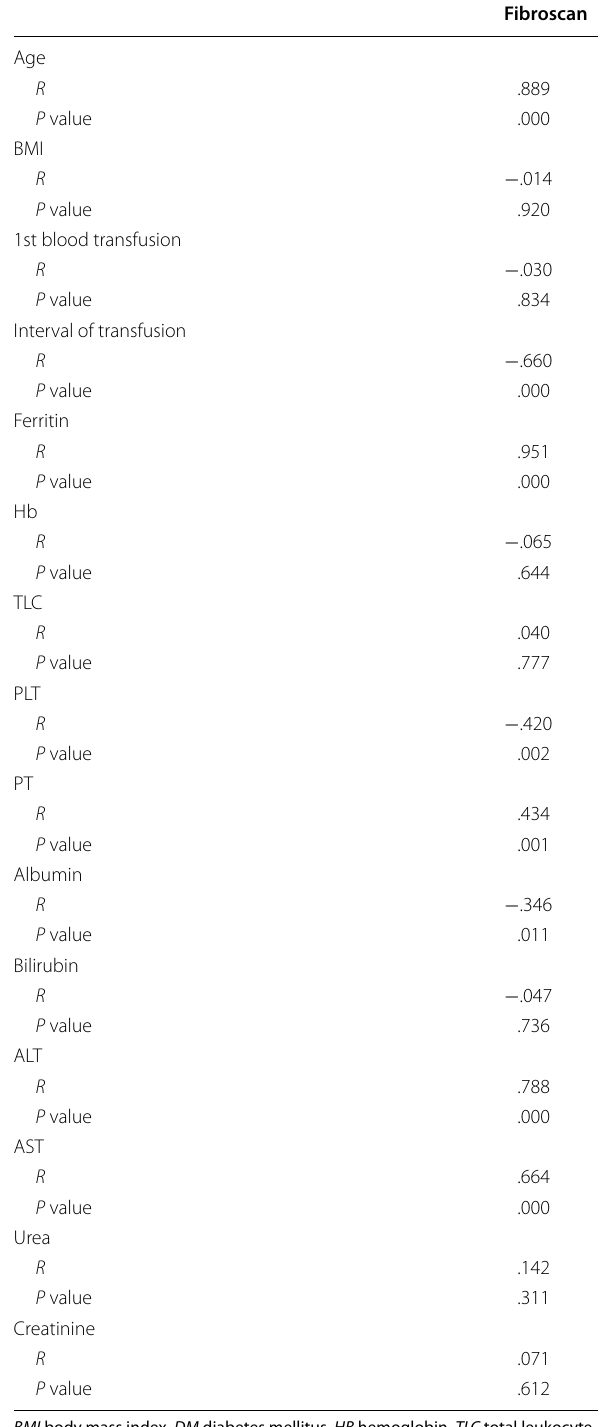
Table 4 Correlation between Fibroscan grades and different parameters (non parametric